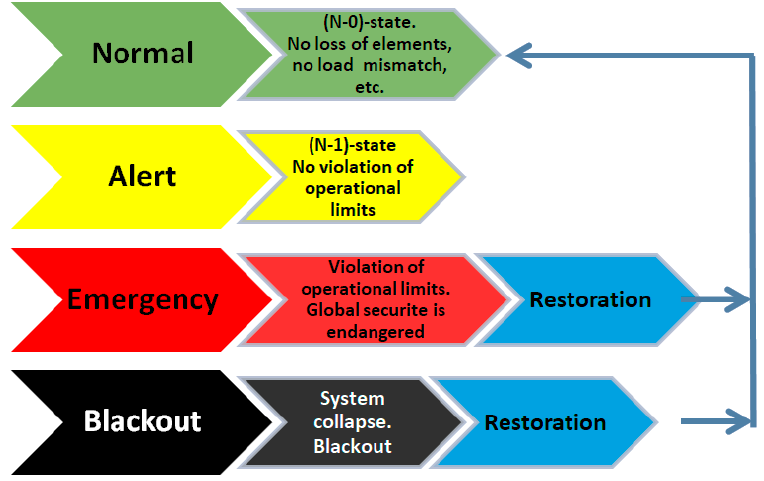
Figure 2. System states.